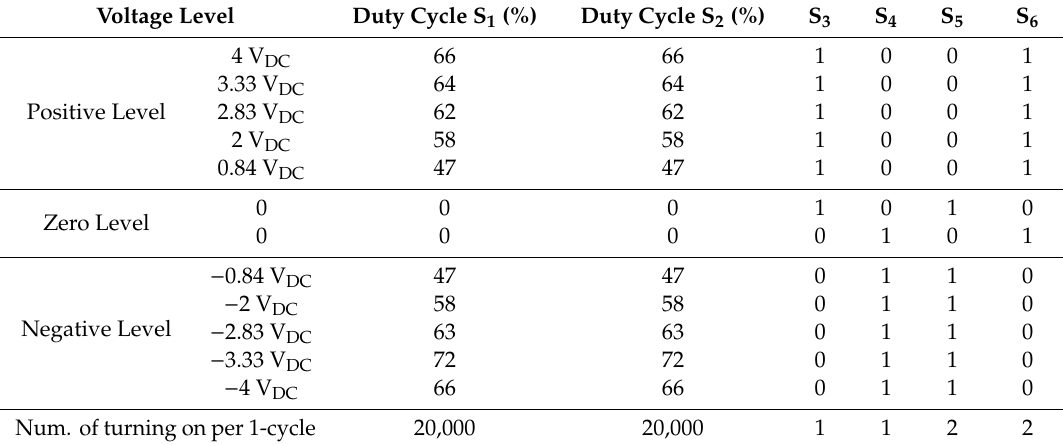
Table 2. Switching table level = 11, gain =